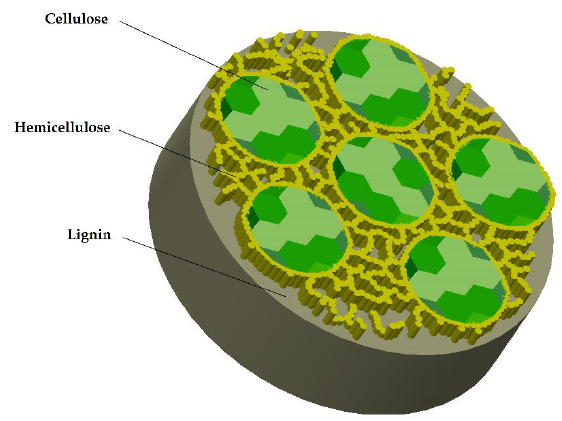
Figure 1. Lignocellulose. Figure 1.